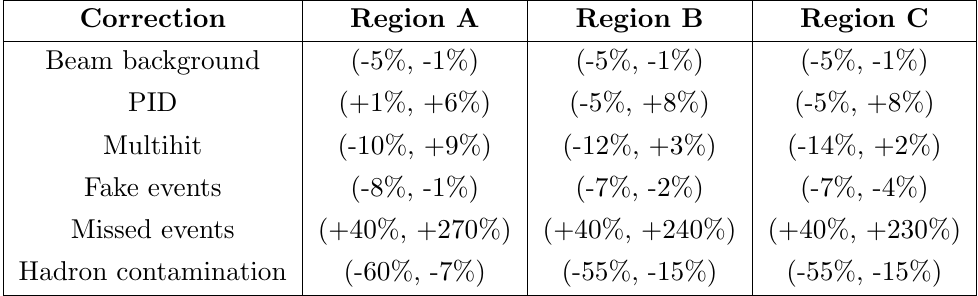
Table 3 . (Minimum, maximum) value of the relative correction factors for each contribution discussed in section 5.2, separately reported for pseudorapidity regions A, B and